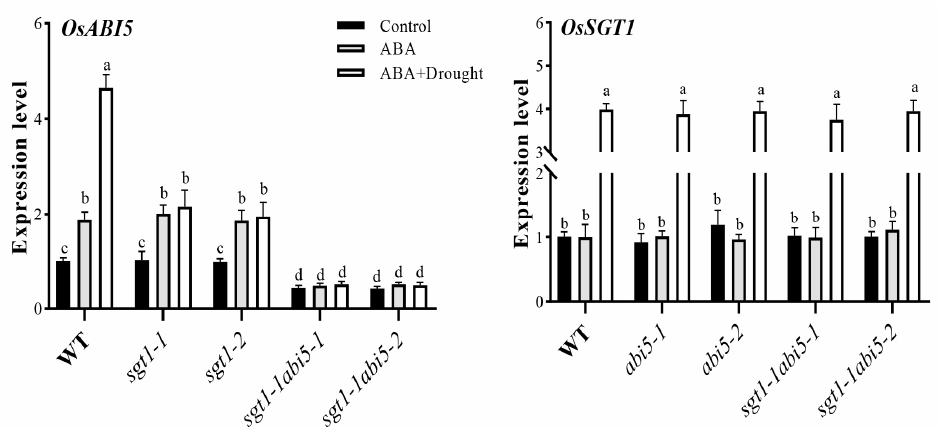
Figure 6. Effects of exogenous ABA on the expression levels of OsABI5 and OsSGT1 . Expression levels of OsABI5 and OsSGT1 were examined in the leaves of wild-type (WT), abi5 , sgt1-1abi5 and sgt1 mutant seedlings treated with exogenous ABA (10 µ M) under drought stress. Difference in letters indicates significant differences according to Tukey’s Multiple Comparison Test ( p < 0.05).